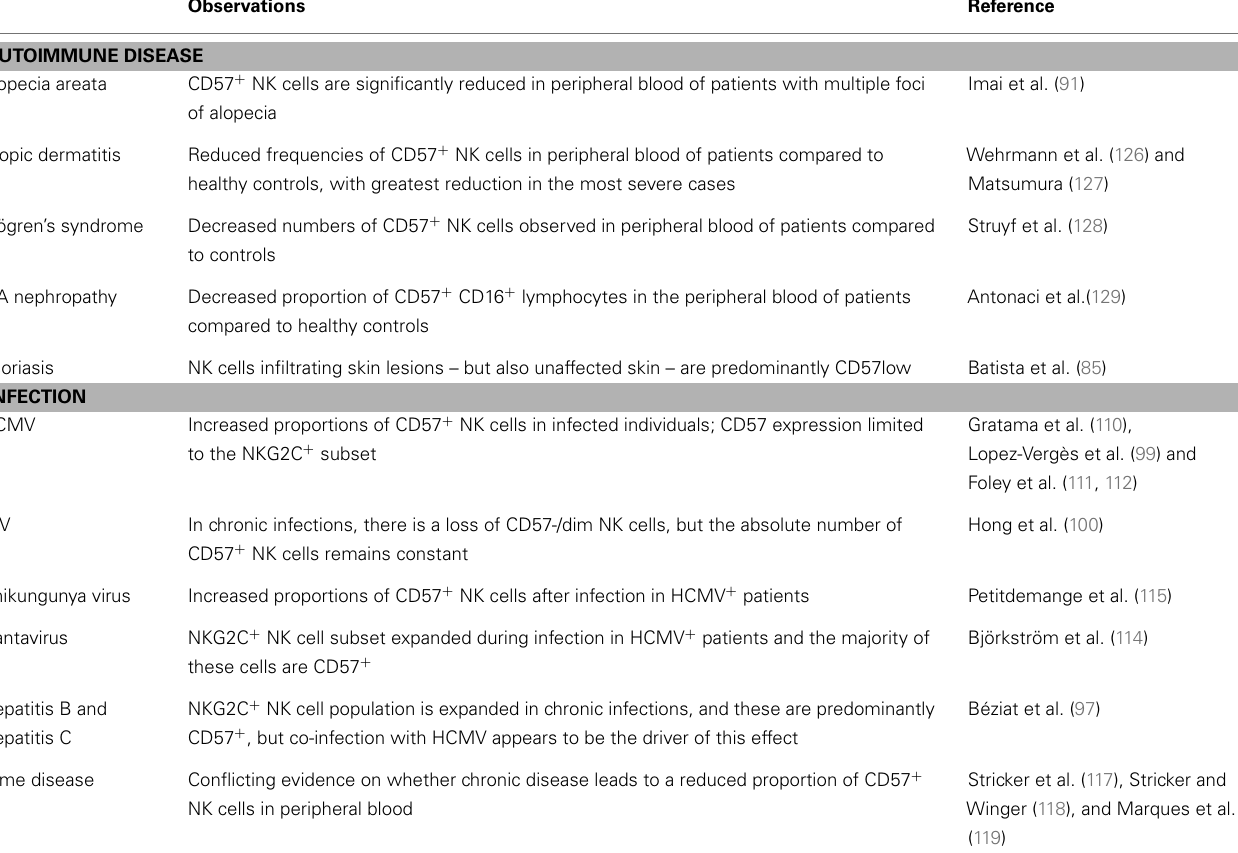
Table 2 |Associations between autoimmune diseases or infections and CD57 expression by NK